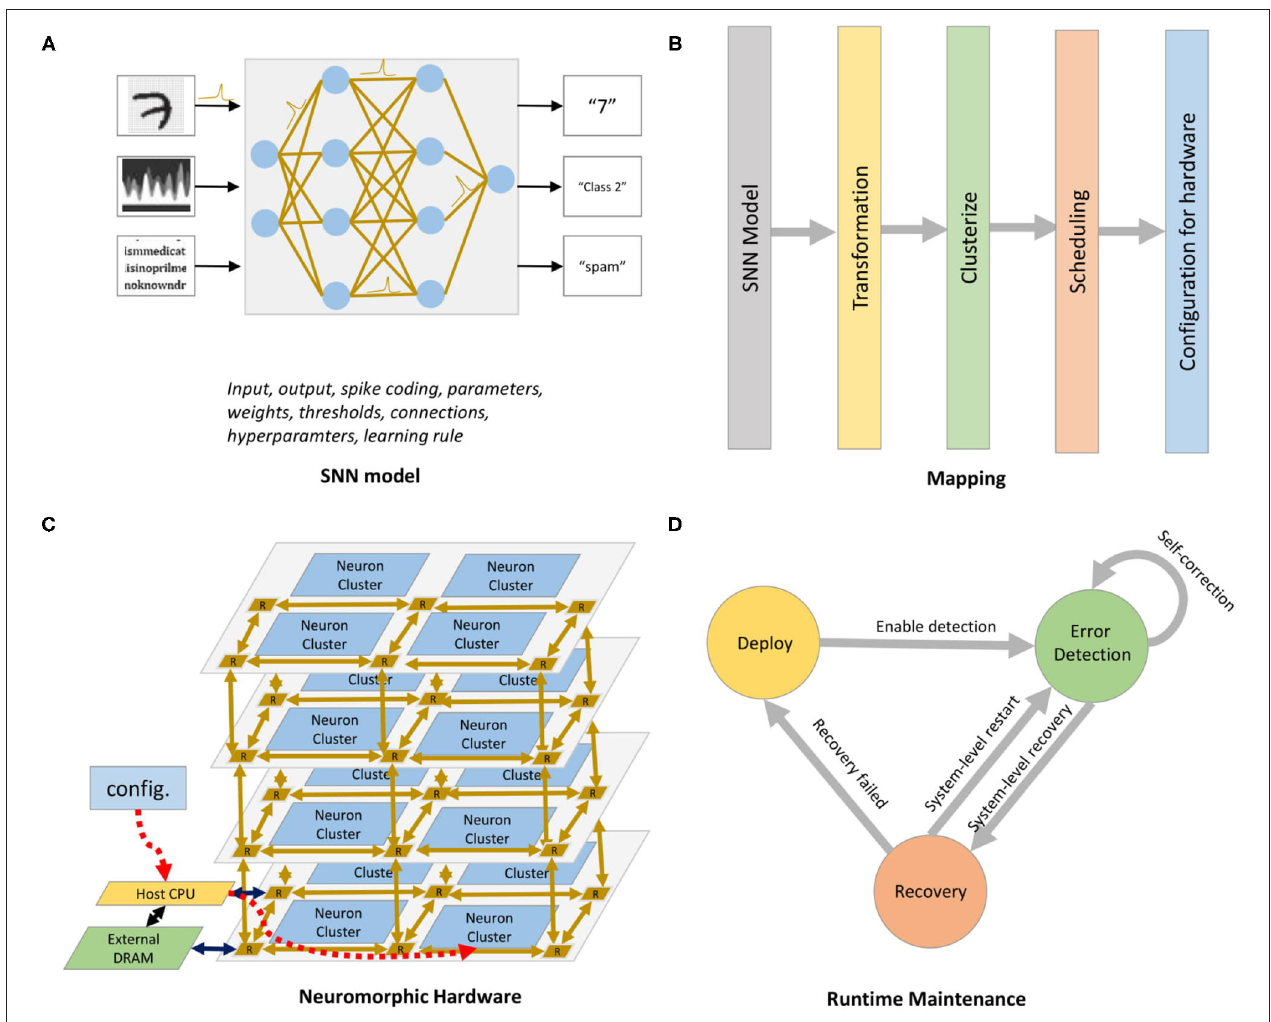
FIGURE 2 | R-NASH platform. (A) SNN model. (B) Mapping into the neuromorphic hardware. (C) R-NASH hardware. (D) Run-time